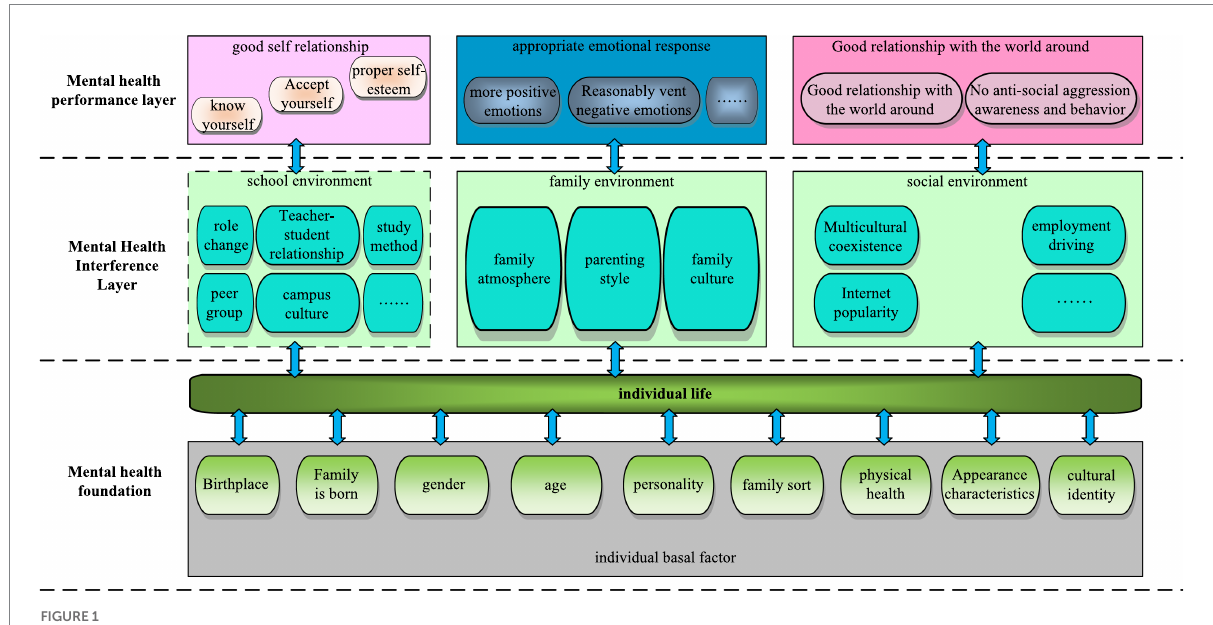
FIGURE 1 The mental model of college students.